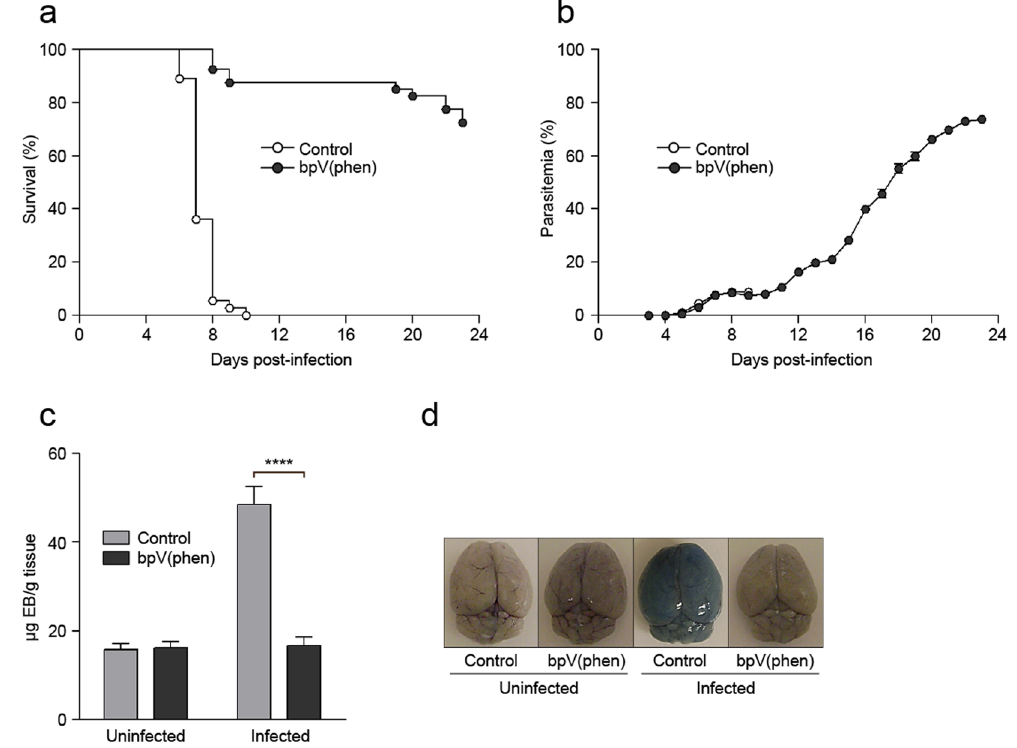
Figure 1. PTP inhibition prevents the development of ECM. ( a ) Survival and ( b ) parasitemia of bpV(phen)- treated mice infected with P. berghei ANKA, ( c ) graph of Evans blue accumulation within the brain and ( d ) representative picture of Evans blue-stained brains. For survival and parasitemia, the cumulative average of six independent experiments is shown. n = 36 for control mice and n = 40 for bpV(phen)-treated mice. P < 0.0001 using the log-rank test. Evans blue assay was performed on day 7 post-infection. n = 5 for uninfected, control mice, n = 4 for uninfected, bpV(phen)-treated mice, n = 7 for infected, control mice and n = 5 for infected, bpV(phen)-treated mice for the Evans blue assay. **** P < 0.0001 using a one-way ANOVA and Tukey’s multiple comparisons